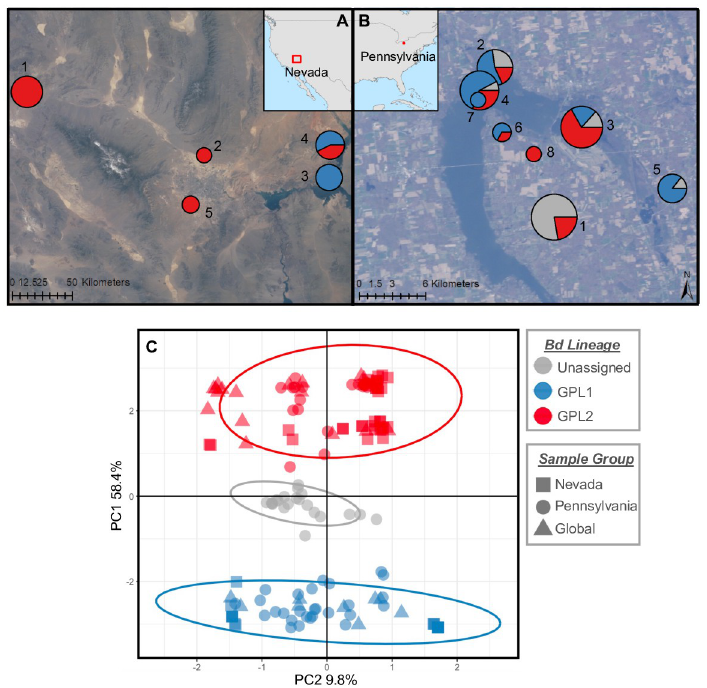
Fig 1. Map of sampling localities for Bd in southern Nevada (A) and northwestern Pennsylvania (B). Individual sampling localities are numbered and represented with a pie chart that shows the proportion of samples belonging to each Bd-GPL sub-lineage as determined using the DAPC clustering analysis. Unassigned samples (in grey) are those with a posterior probability of assignment to either group < 0.99. Pie charts are scaled in size according to the number of samples collected at that site. (C) PCA calculated from 129 SNPS using the combined dataset of southern Nevada (N = 52, squares), northwestern Pennsylvania (N = 71, circles), and global reference samples (N = 26, triangles). Symbols and ellipses colored as in maps above. Satellite imagery courtesy of the Earth Science and Remote Sensing Unit, NASA Johnson Space Center (http://eol.jsc.nasa.gov).